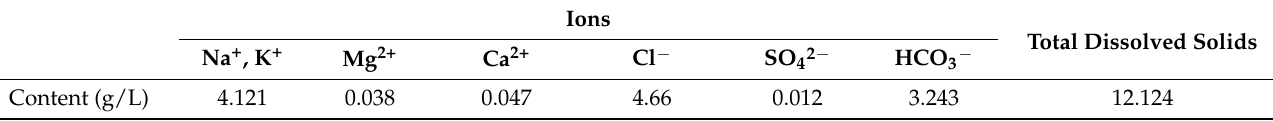
Table 2. Composition of simulated formation